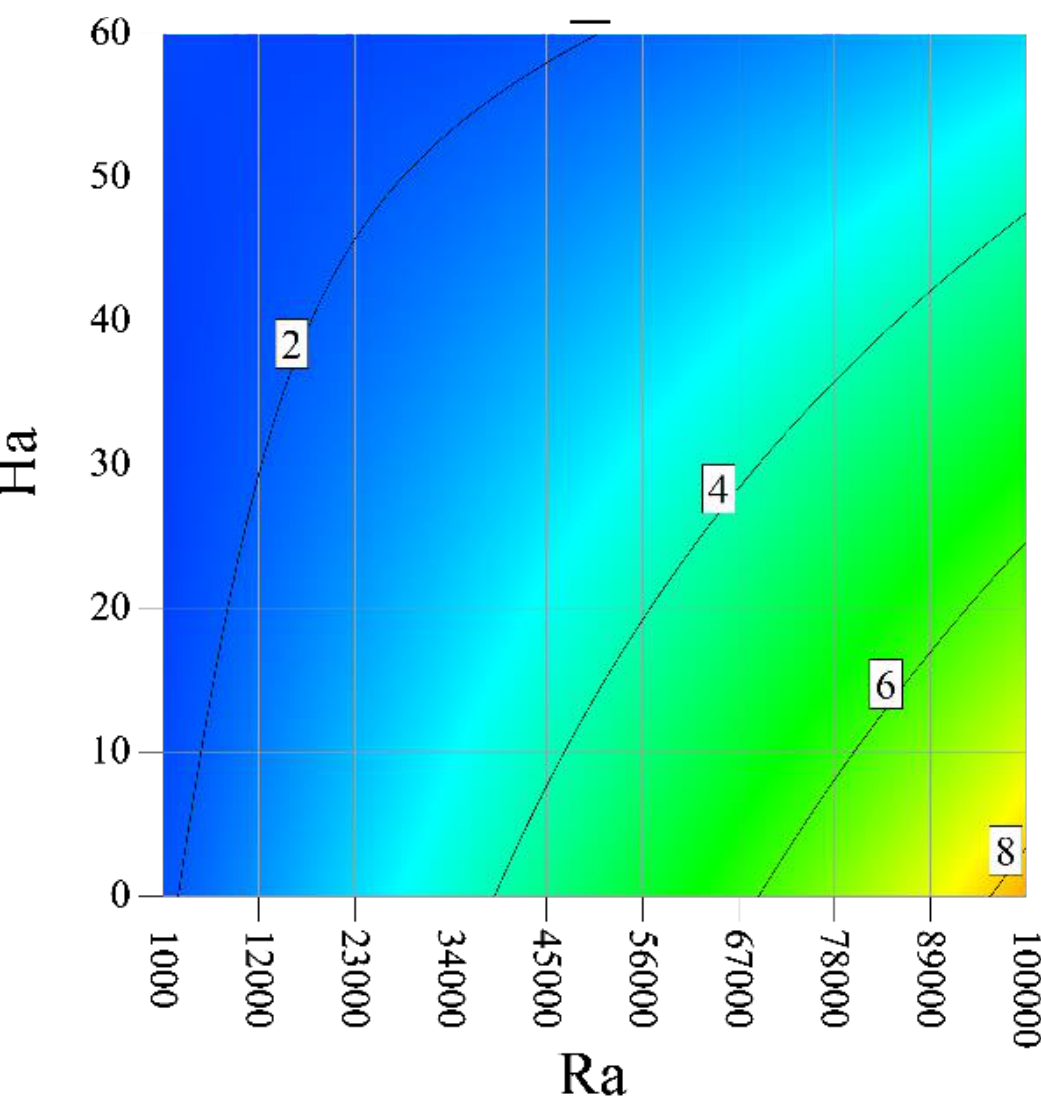
Figure 6. EGN for different Ra and Ha when W = 0.5, H = 0.7, and the volume fraction is 0.3%.